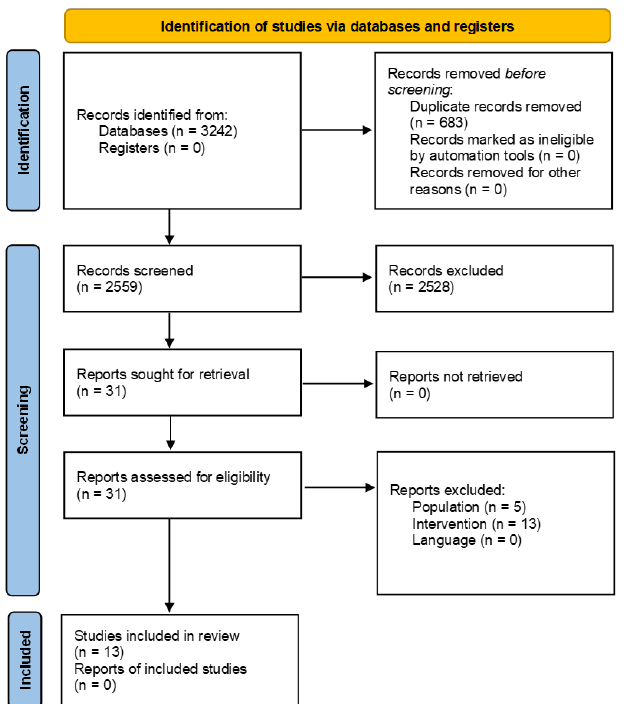
Figure 2. Flow diagrams of literature review for musculoskeletal pain studies. This figure was adapted from the Preferred Reporting Items for Systematic Reviews and Meta-Analyses (PRISMA) statement.